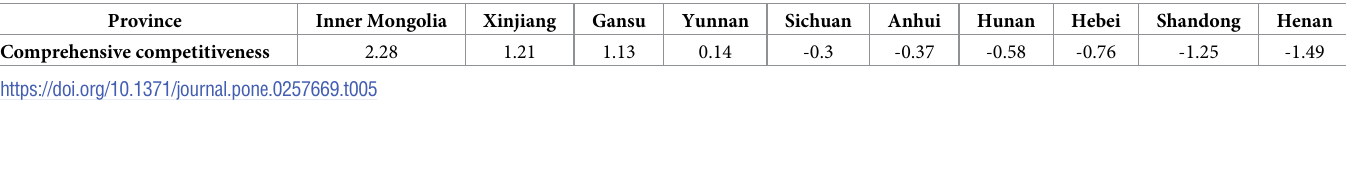
Table 5. The ranking of comprehensive